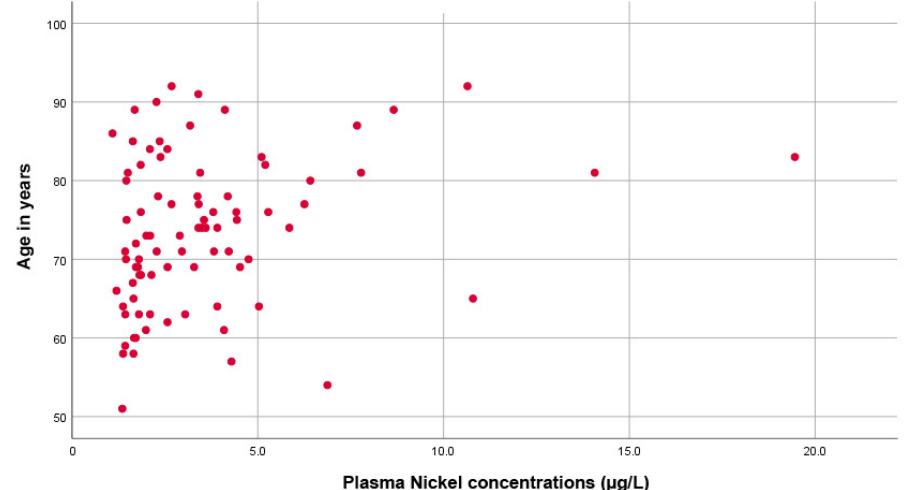
Figure 2. Scatter plot showing the direct proportional correlation between age and plasma nickel levels. The correlation was even more significant in the group of PCa patients ( p = 0.001, rho = 0.483) compared to the control group ( p = 0.811, rho = 0.040). Kruskal–Wallis tests found no significant differences between Ni levels and educational levels ( p = 0.101), employ- ment status ( p = 0.488), or marital status ( p = 0.065). No significant changes were observed in the plasma Ni concentration between men with PCa who had or had not undergone a